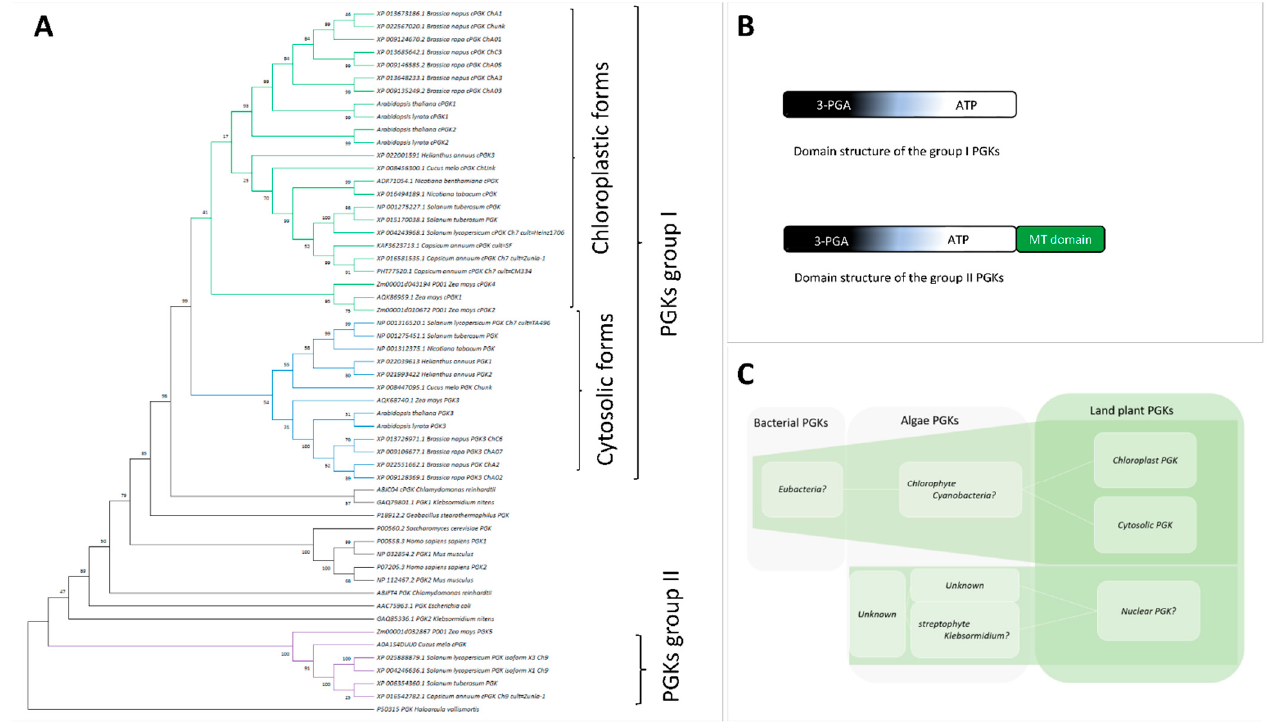
Figure 2. Maximum likelihood tree of 55 PGKs protein sequences reveals 2 distinct groups of PGKs in the plant . ( A ) The phylogenetic tree obtained with MEGA version 11 using the PGK of Haloarcula vallimortis , an archaea, as the root. The protein sequences are retrieved from GenBank (https://www.ncbi.nlm.nih.gov/genbank/, accessed on 24 October 2021), maize (https://www.maizegdb.org/, accessed on 24 October 2021), and cucurbits database (http://cucurbitgenomics.org/organism/3, accessed on 24 October 2021) for a conservation analysis. The retrieved sequences are aligned with MUSCLE (https://www.ebi.ac.uk/Tools/msa/muscle/, accessed on 26 October 2021). Subsequently, using protTest software V3.4.2 (https://github.com/ddarriba/prottest3/releases, accessed on 25 October 2021), the WAG matrix is predicted as the best model of amino acids substitution. The obtained tree shows 2 groups (group I and group II) of PGKs that likely have a distinct origin. Group I contains plant cytosolic and chloroplastic PGKs coloured in blue and green, respectively. This group is closely related to Chlamydomonas reinhardtii chloroplastic PGK, which might be its ancestor [29]. A second class of PGK, in purple colour, forms group II, showing a striking divergence from group I. The members of this group all have a predicted methyltransferase (MT) domain (IPR029063) [30]. Klebsormidium nitens has a chloroplastic PGK (GAQ85336.1) displaying a homologous structure domain, as opposed to the plant group II PGKs. PGKs from others organisms are black-coloured. Organism names are preceded by the protein accession numbers for each protein sequence. ( B ) Illustration diagrams of domains found in group I and group II plant PGKs. 3-PGA (in black background) and ATP (in white background) represent sites found in the PGKs group I and group II. An additive methyltransferase domain (MT domain) is also observed in group II PGKs. ( C ) Proposed evolution model of the described plant PGKs based on our phylogenetic analysis.